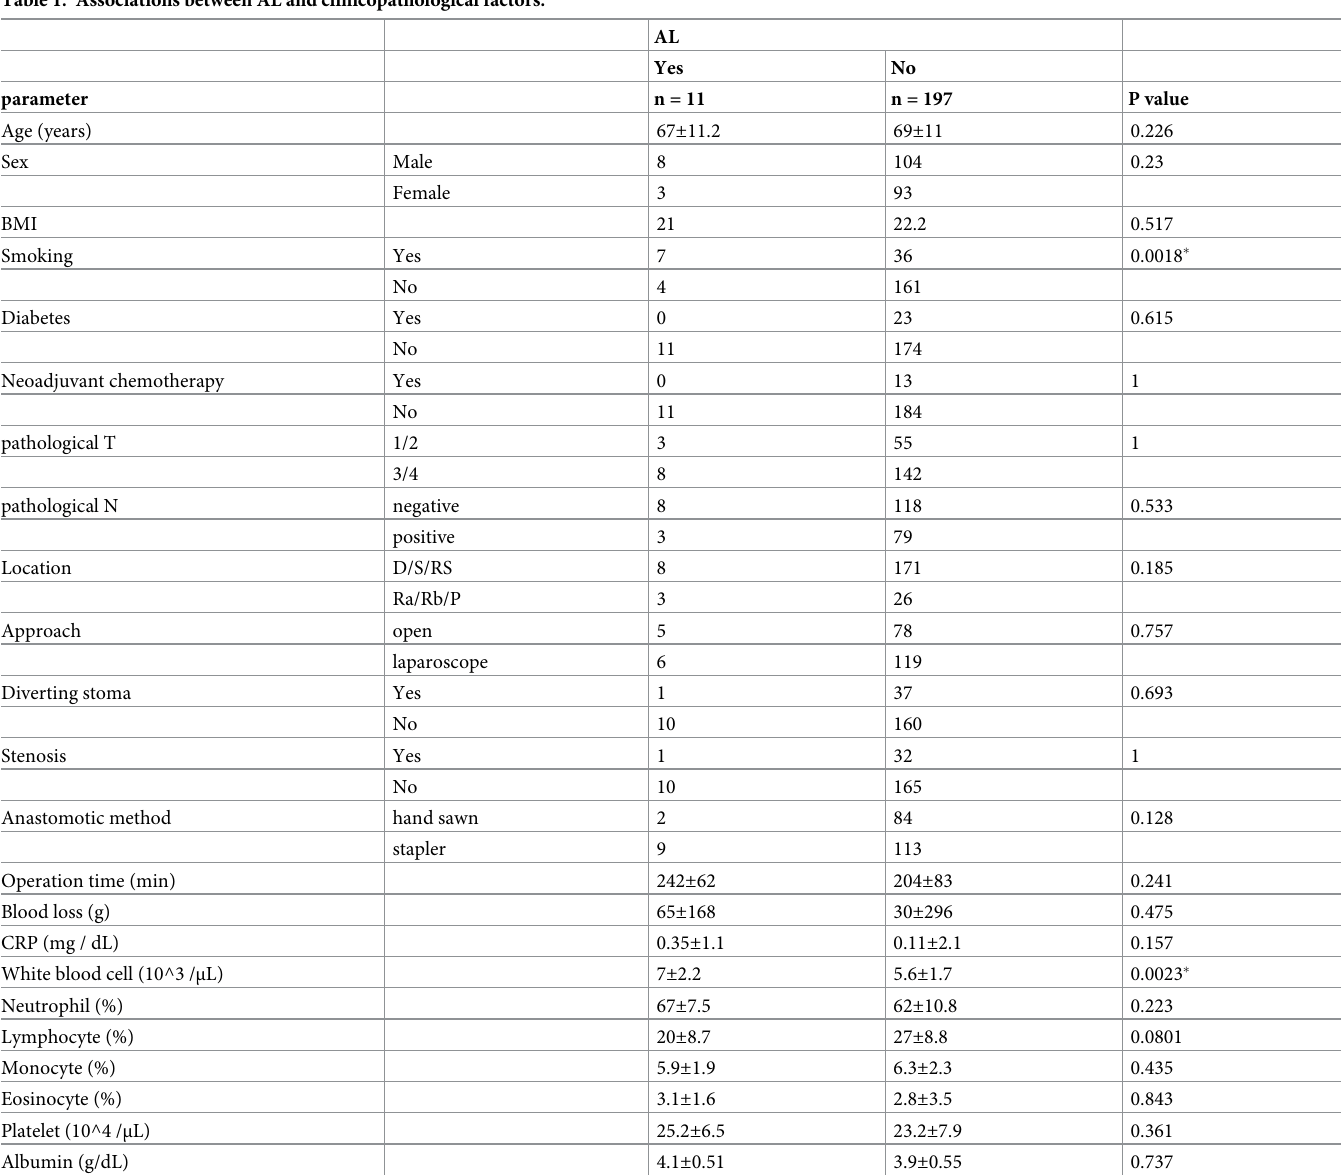
Table 1. Associations between AL and clinicopathological factors.